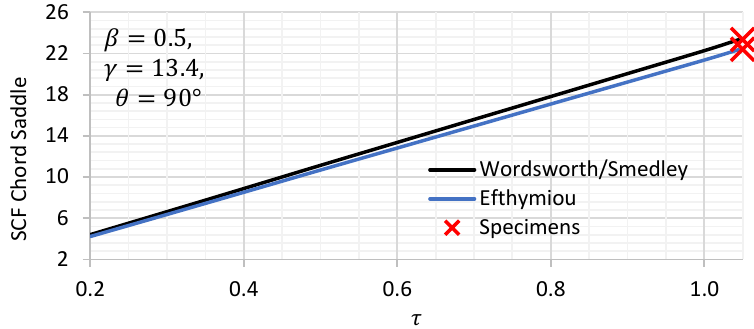
Figure 2. Axially loaded DT joints: chord SCF variation with 𝛽 for a set of joint parameters ( 𝜃 , 𝛾 and 𝜏 ). Figure 3. Axially loaded DT joints: chord SCF variation with 𝜏 for a set of joint parameters ( 𝜃 , 𝛾 and 𝛽 ).